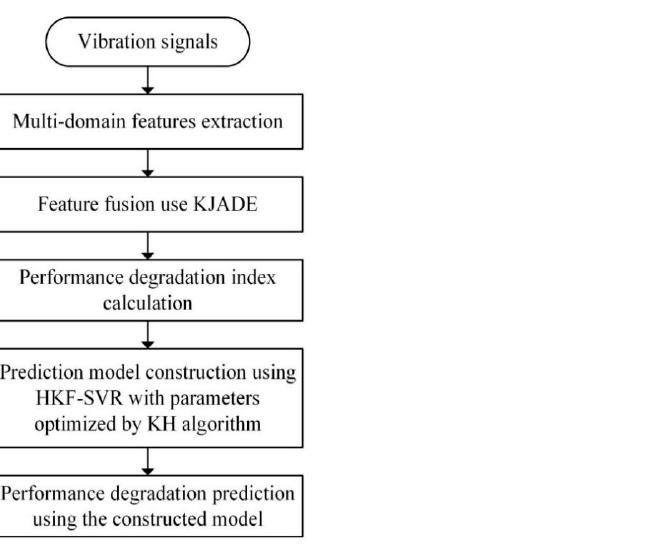
Figure 2. Flow chart of performance degradation prediction by Hybrid Kernel Function-Support Vector Regression (HKF–SVR). Table 2. Time-domain features.